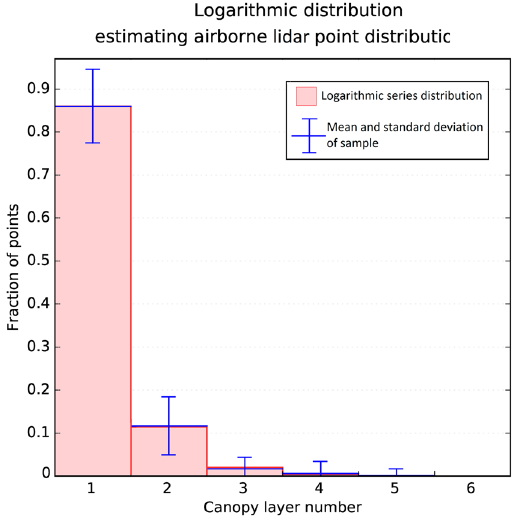
Figure 3. Logarithmic series distribution estimating observed fractions of LiDAR points recorded for different canopy layers. The distribution has a discrete domain supporting natural numbers.